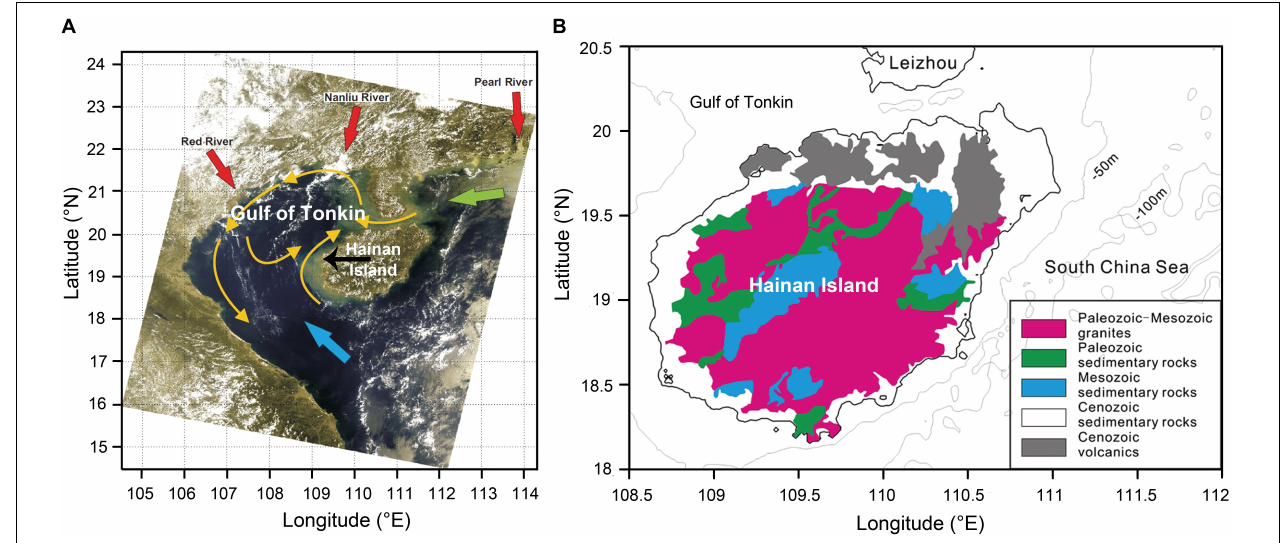
FIGURE 1 | (A) Satellite image of the Gulf of Tonkin from ESA ENVISAT MERIS, showing the general circulation patterns (yellow arrows) and material inputs (riverine: red arrows; coast parallel: green arrow; and marine: blue arrow). Black arrow on the Hainan Island represents riverine input from the island to the Gulf of Tonkin [modified from Bauer et al. (2013)]. (B) A simplified map of Hainan Island showing major geological formations in the island [modified from Shi et al. (2011), Zhao et al. (2015)]. See text for more